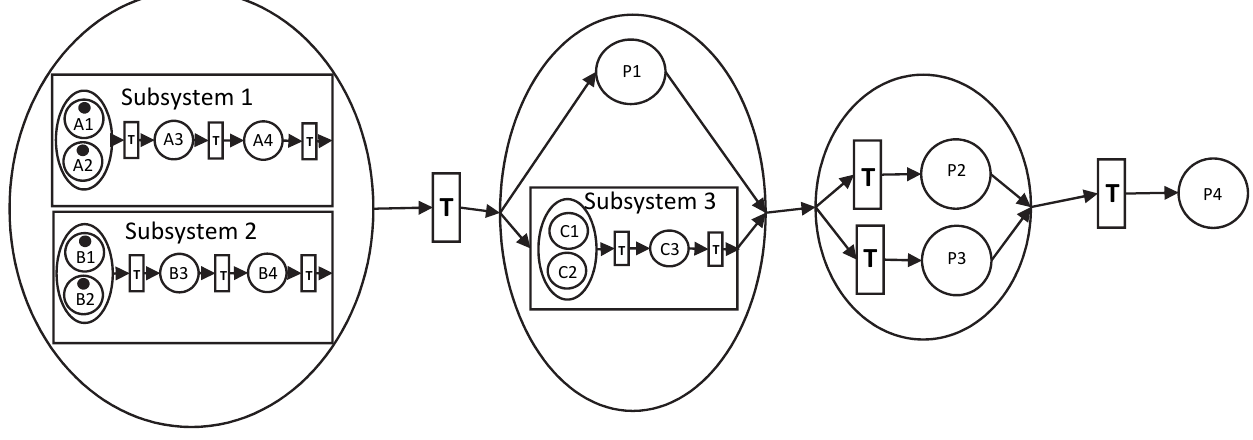
Fig. 3. Complete system model with tokens.